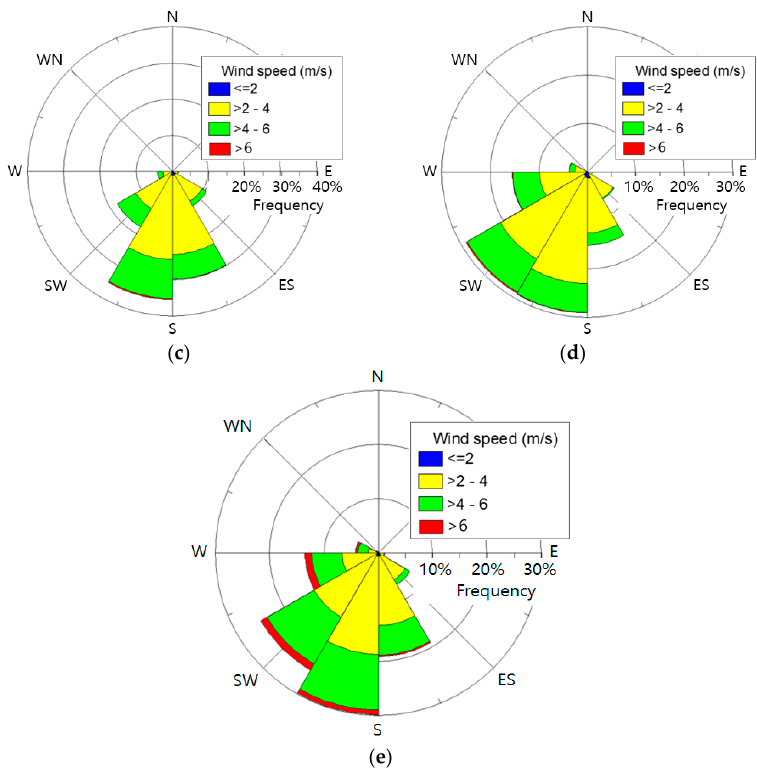
Figure 3. Wind rose diagrams for Deokjeok-do from 2005 to 2015 at 10 m from local ground ( a ) Winter; ( b ) Spring; ( c ) Summer; ( d ) Autumn; ( e ) Overall.